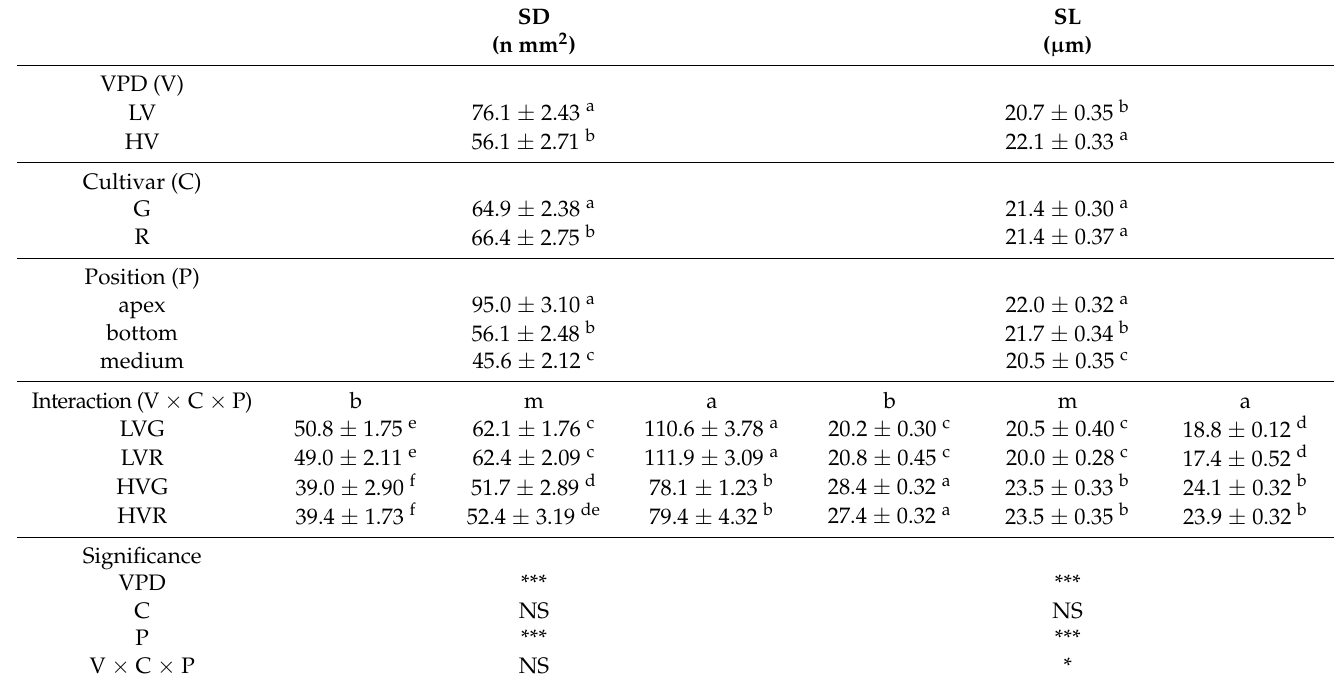
Table 3. Stomatal traits in terms of stomatal density (SD) and stomatal length (SL) from green (G) and red (R) Salanova plants grown under low (LV) and high (HV) VPD with differences within the leaf parts: b, bottom; m, medium; a, apex. All data are reported as mean ± se. Different letters indicate significant differences, according to Tukey test ( p < 0.05).